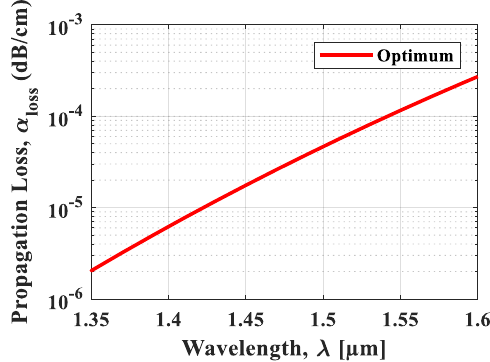
Figure 8. Propagation loss curve of the proposed hexagonal photonic crystal fiber (H-PCF) for optimal design parameters ( Λ = 0.76, d 1 / Λ = 0.95, and d 2 / Λ = 0.80).